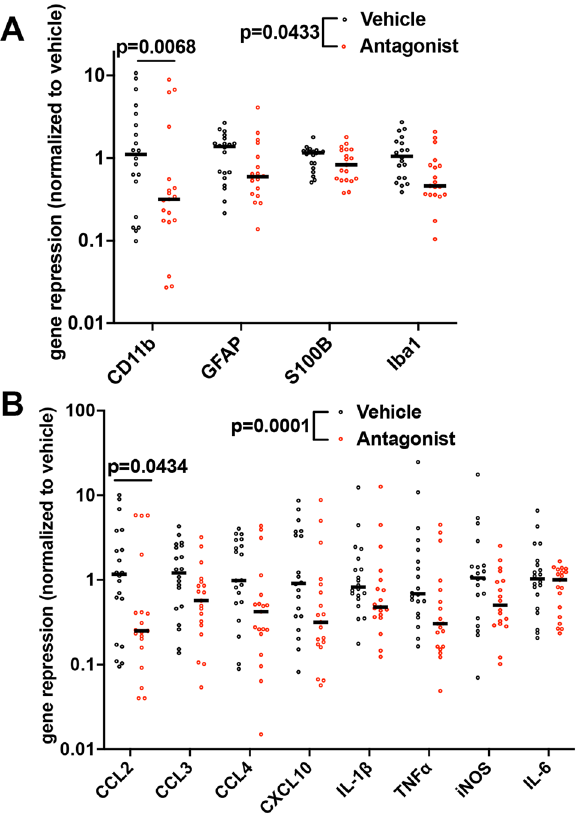
Figure 7. CCR2 antagonism dampens hippocampal glial and inflammatory markers three days after SE. ( A ) Horizontal line indicates median fold repression of the glial mediators in hippocampus and is plotted referenced to the mean of the vehicle-treated group (paired t test, p = 0.0433, veh = 20 and antag n = 19 in all groups with one antagonist-treated outlier removed from GFAP group (n = 18)). CD11b was statistically significant ( p = 0.0068) by one-way ANOVA (the effect of treatment, F(7, 147) = 2.843, p = 0.0083) after Sidak correction. The adjusted p value is shown. Symbols represent data from each mouse. ( B ) Horizontal line indicates median fold repression of the inflammatory mediators in hippocampus and is plotted referenced to the mean of the vehicle-treated group (paired t test, p = 0.0001, veh = 20 and antag n = 19 in all groups with one antagonist- treated mouse removed from the iNOS group (n = 18)). CCL2 was statistically significant ( p = 0.0434) by one- way ANOVA (the effect of treatment, F(15, 295) = 2.470, p = 0.0020) after Sidak correction. The adjusted p value is shown. Symbols represent data from each